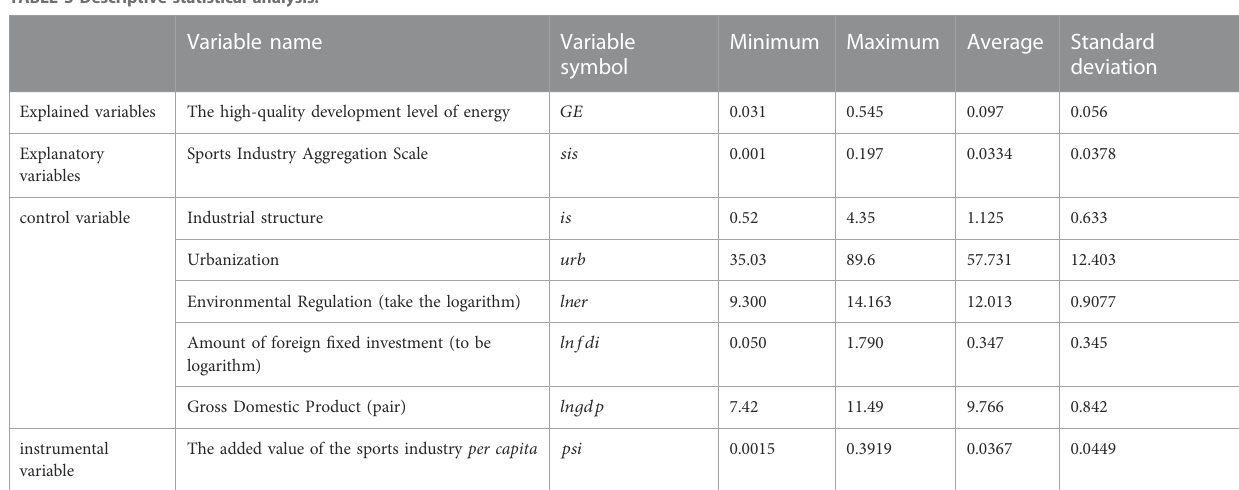
TABLE 3 Descriptive statistical analysis.